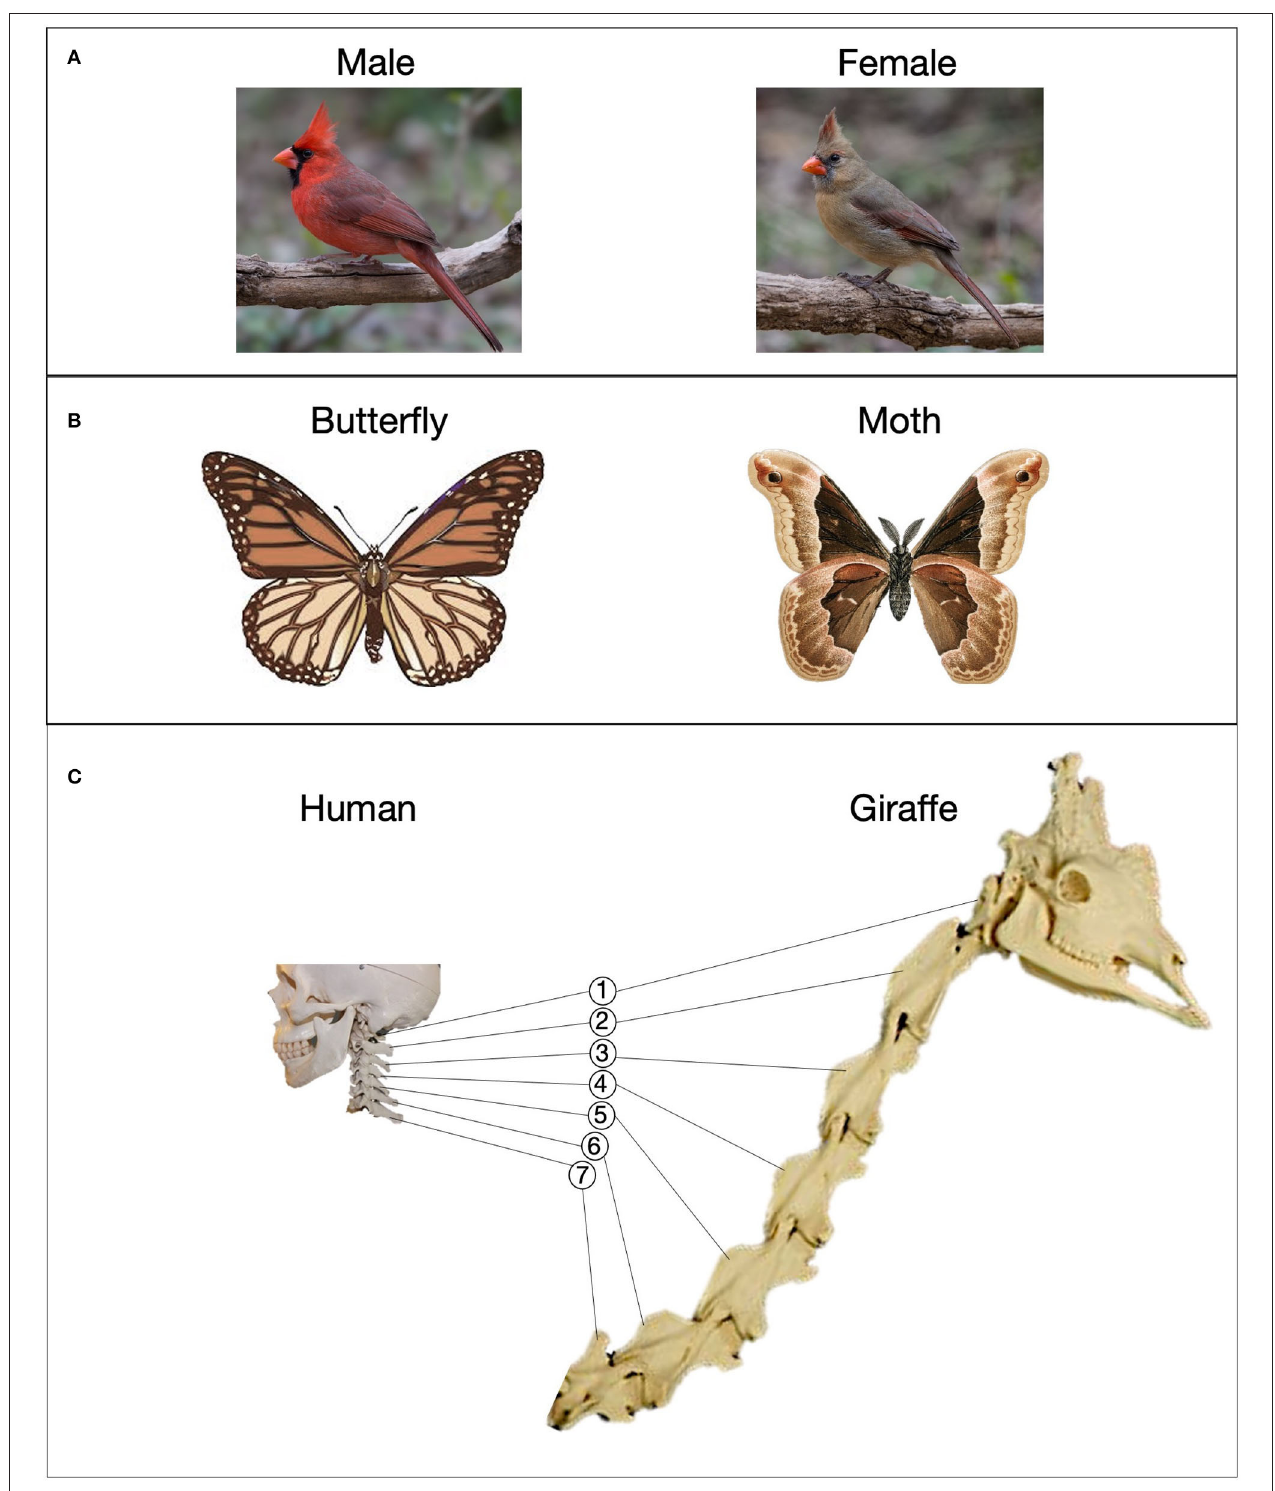
FIGURE 1 | Examples of comparisons involving natural specimens. (A) A male and female northern cardinal. Photographs by Andy Morffew; (B) a butterfly and a moth; (C) the cervical vertebrae of a human and a giraffe.